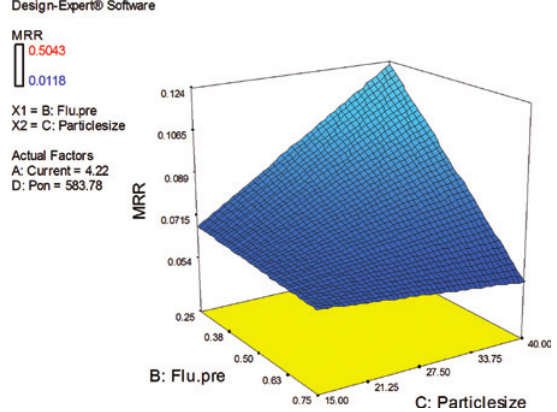
Figure 6 Interactive effect of flushing pressure and particle size on MRR.